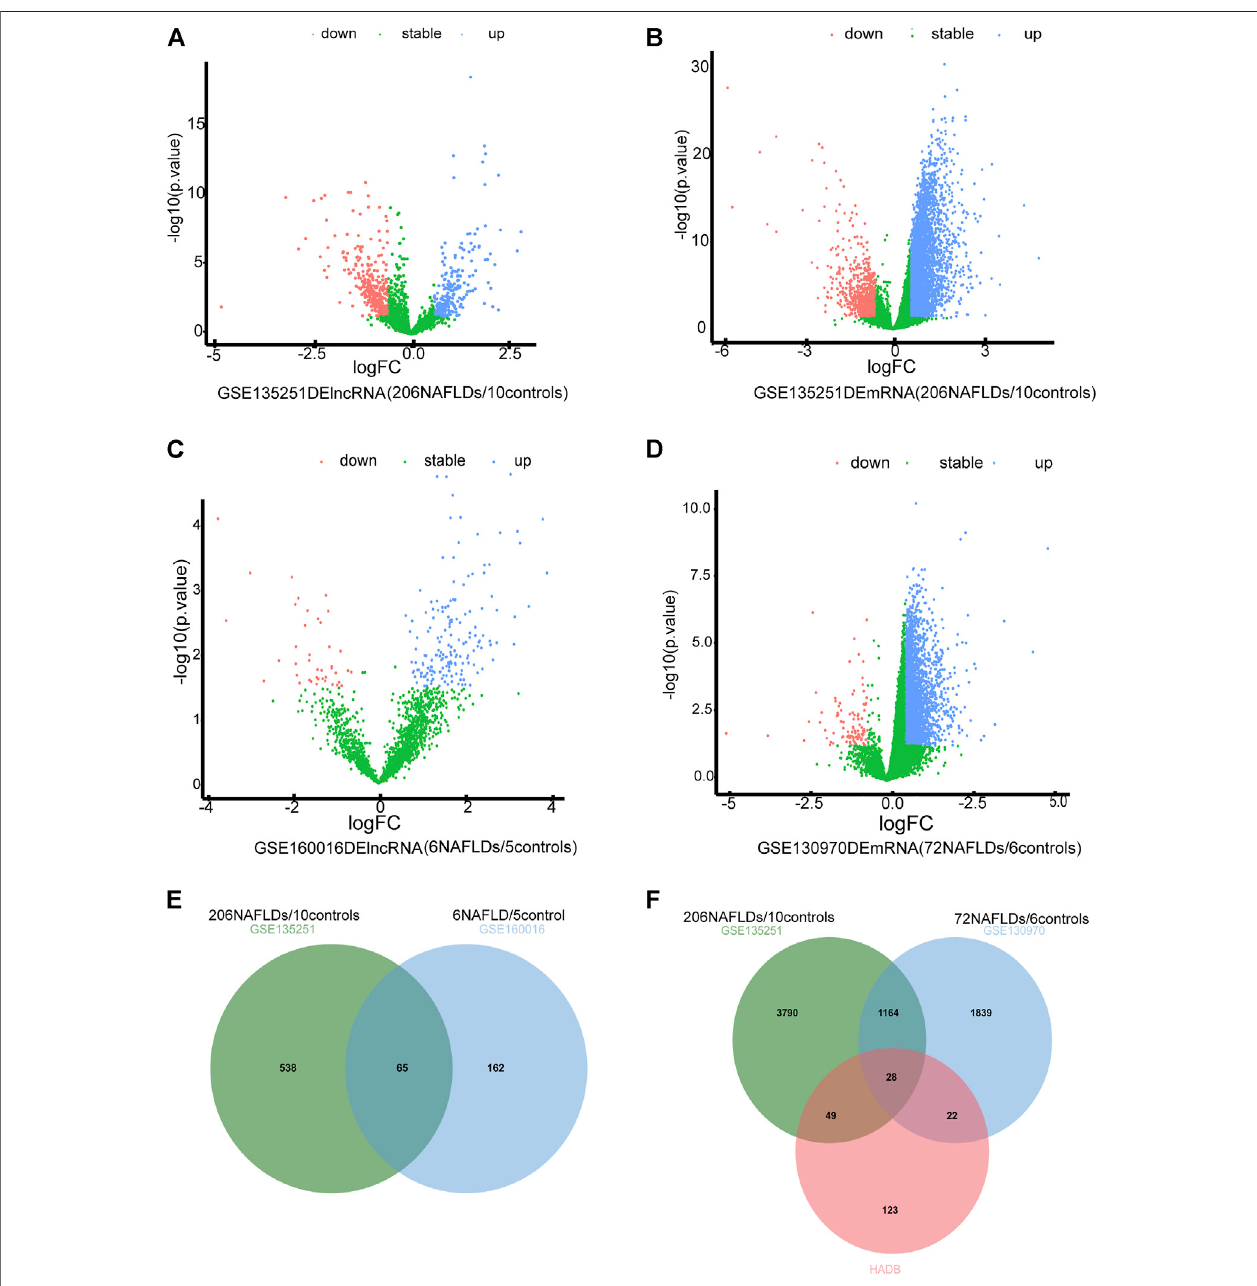
FIGURE 2 | Differentially expressed autophagy-related genes and lncRNAs. (A) volcano plot of DElncRNAs in GSE135251 (|log2 fold change| > 0.58; p < 0.05) (B) volcano plot of DEmRNAs in GSE135251 (|log2 fold change| > 0.58; p < 0.05). (C) volcano plot of DElncRNAs in GSE160016 (|log2 fold change| > 0.58; p < 0.05). (D) volcano plot of DEmRNAs in GSE130970 (|log2 fold change| > 0.58; p < 0.05). (E) Intersection of DElncRNAs of GSE135251 and GSE160016. (F) Intersection of DEmRNAs of GSE135251 and GSE130970 with autophagy genes of HADb.